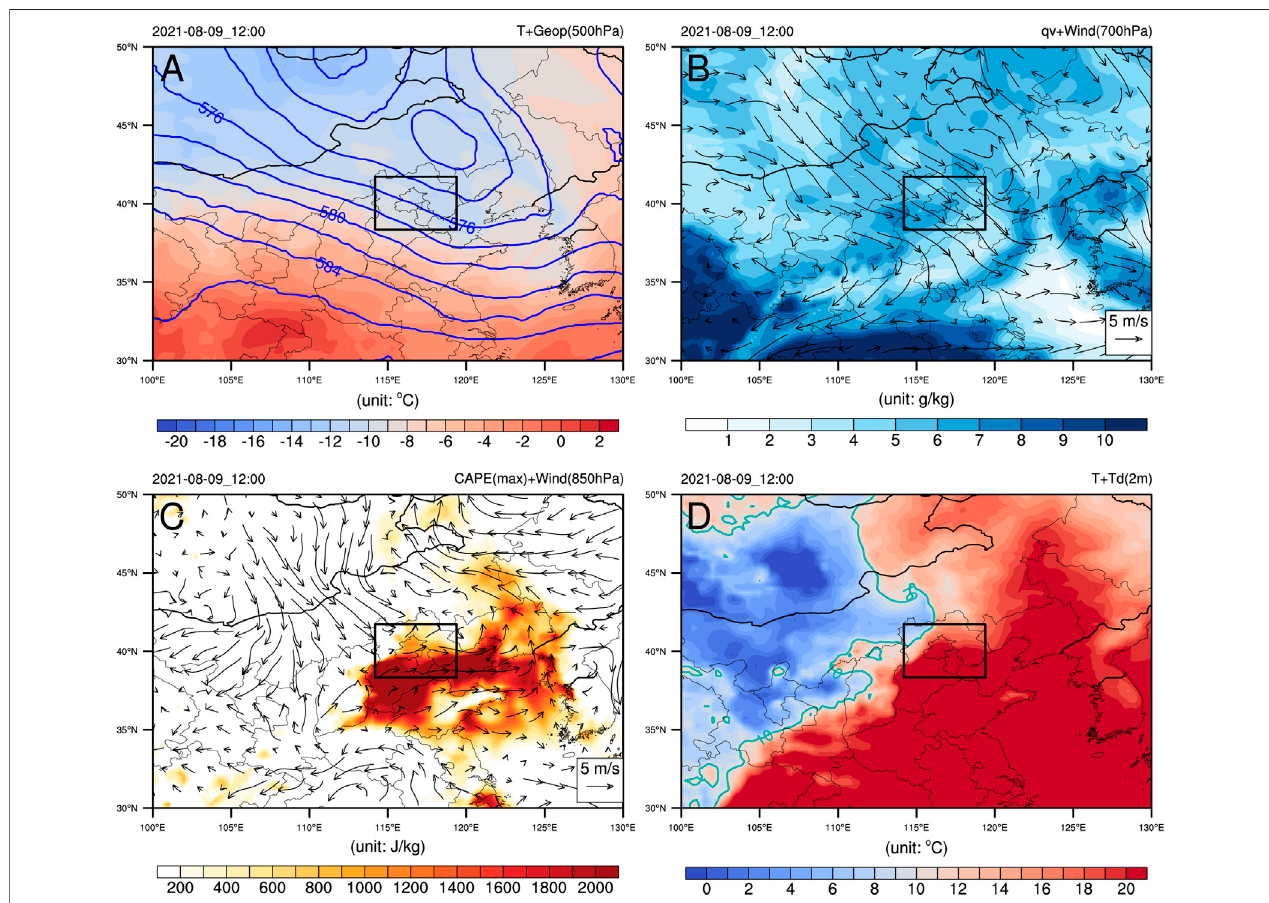
FIGURE 2 | Background of general circulation of supercell at 1200 UTC 9 August in terms of (A) geopotential height (blue contours, unit: gpm) and temperature (shadedcolors,unit: ° C)at500 hPa, (B) speci fi chumidity(shadedcolors,unit:gkg − 1 )andwind(vectors,unit:ms − 1 )at750 hPa, (C) convectiveavailablepotentialenergy (shaded colors, unit: J kg − 1 ) and near-surface wind (vectors, unit: m s − 1 ), and (D) near-surface temperature (shaded color, unit: ° C) and dew temperature (green contours, unit: ° C). The black box denotes the regions where the supercell was active.